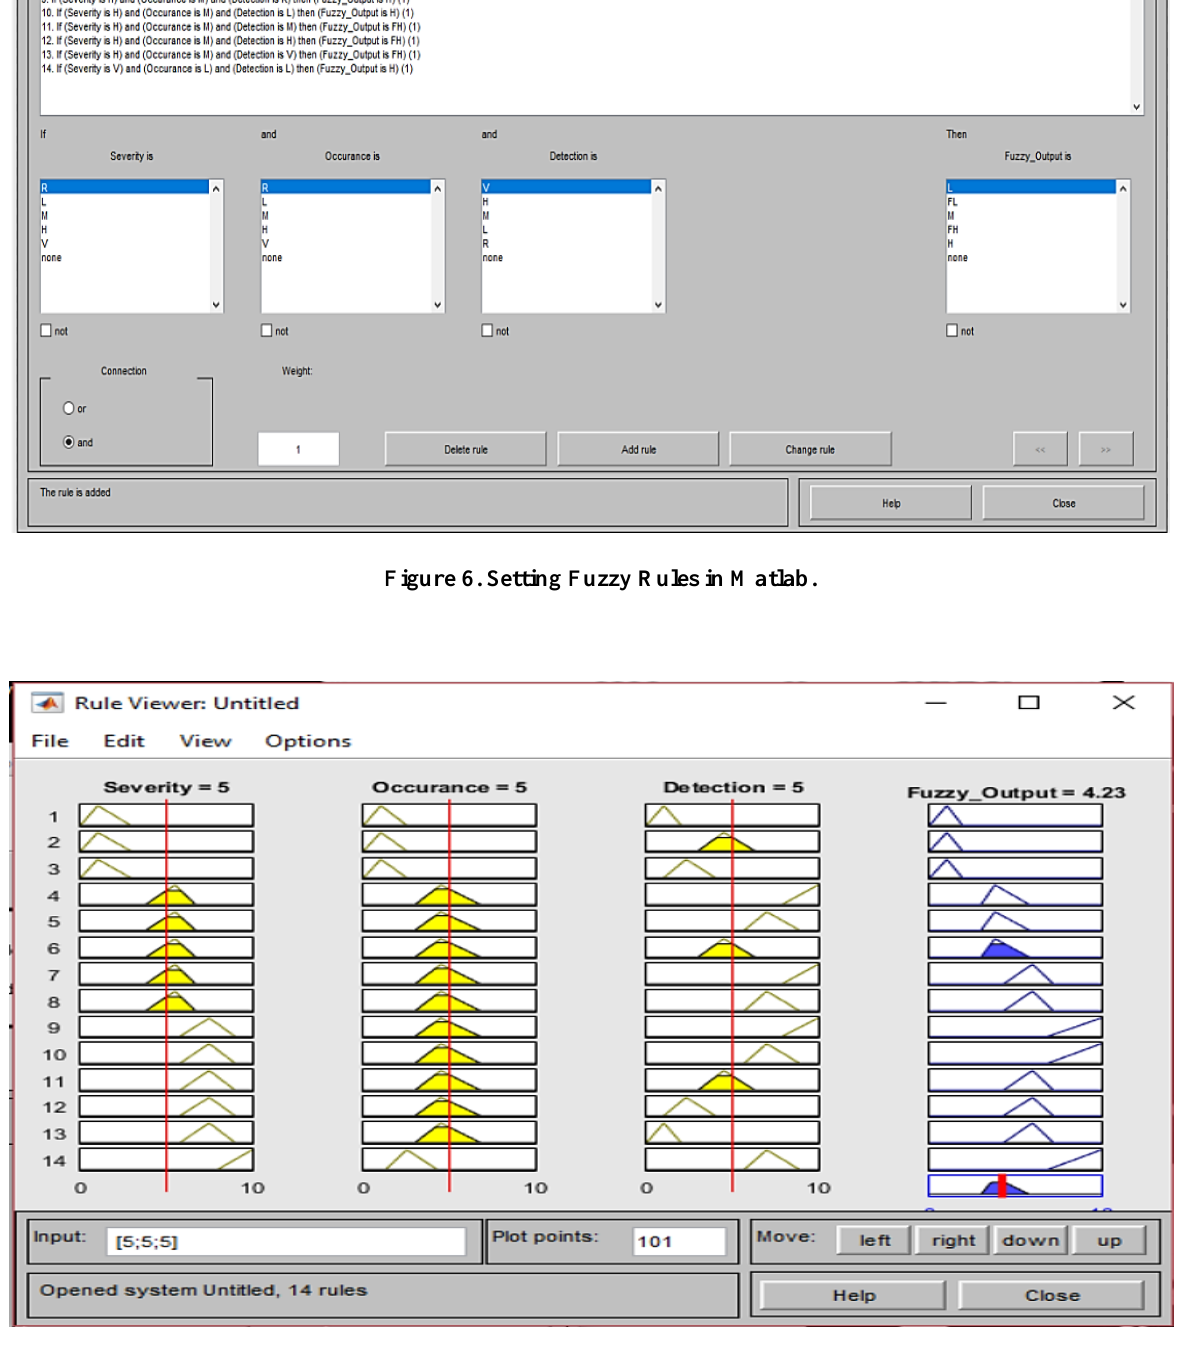
Figure 7. Inputs and Output Views of Risk Priority in